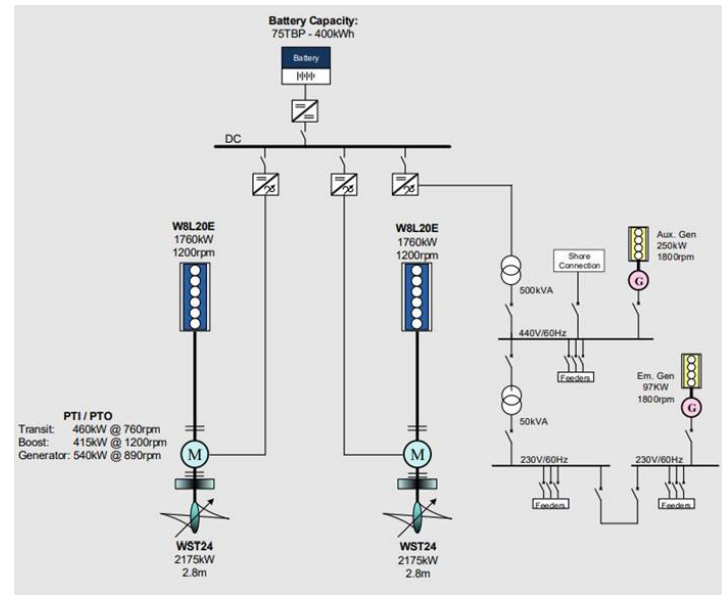
Figure 10. Single-line diagram of the diesel – mechanic hybrid system [71].